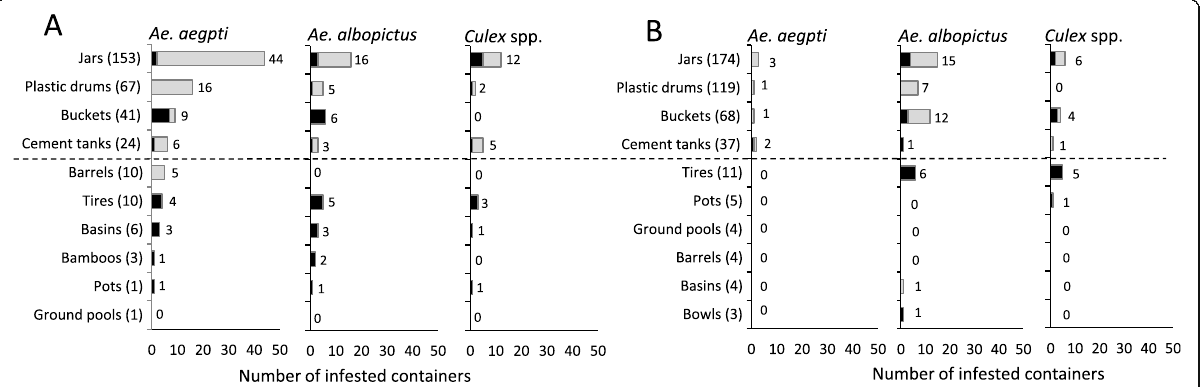
Fig. 3 Comparison of accumulated number of containers that were examined and infested with Ae. aegypti , Ae. albopictus , and Culex spp. mosquito larvae and whether the associated water was in daily use or stagnant in two villages. The analyzed data showed the total numbers of infested containers that were obtained in pre-intervention period (October 2017) and intervention periods (February, July, and September 2018) in the control village ( a ) and in the treated village ( b ). The numbers in parenthesis indicate the sample size for each type of containers that were examined, while the numbers without the parenthesis indicate infested number mosquito larvae. The dash line indicated division as the upper were 4 main container types that commonly used in the village and were habitats for mosquito as the analysis result was described in the “ Materials and methods ” section. The grey bar indicated water in daily use, and the black bar indicated stagnant